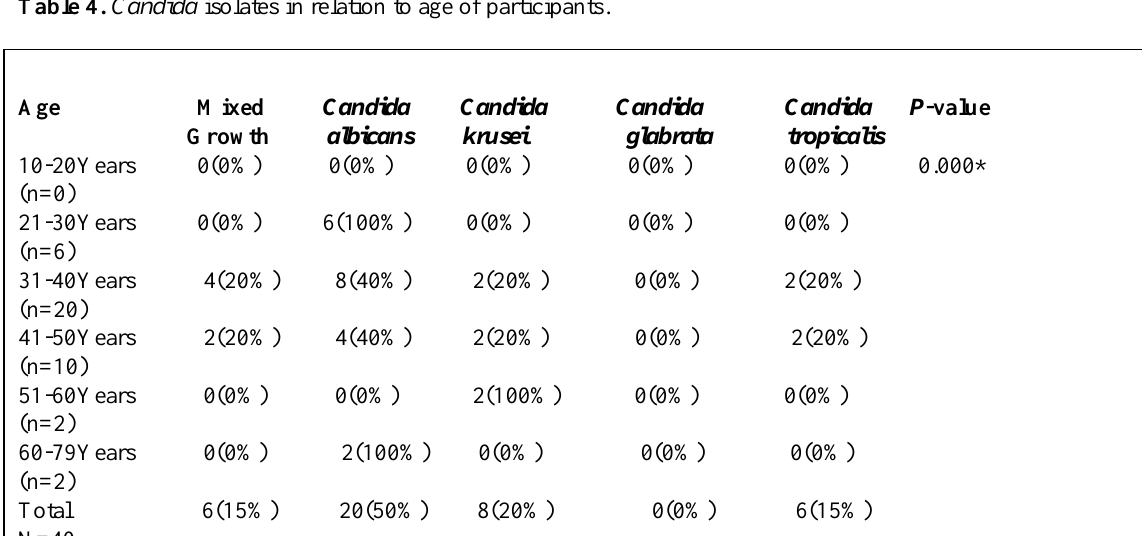
Table 4. Candida isolates in relation to age of